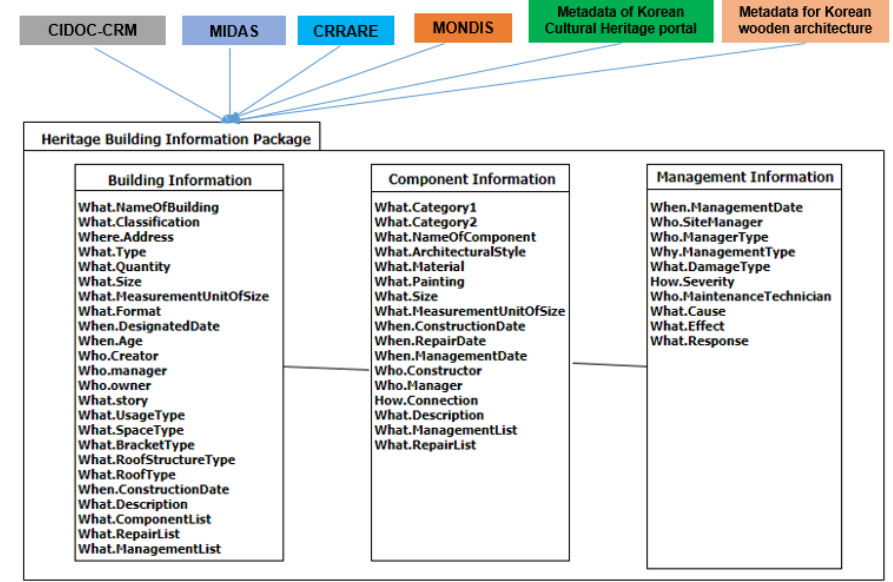
Figure 5. Heritage building information metadata.